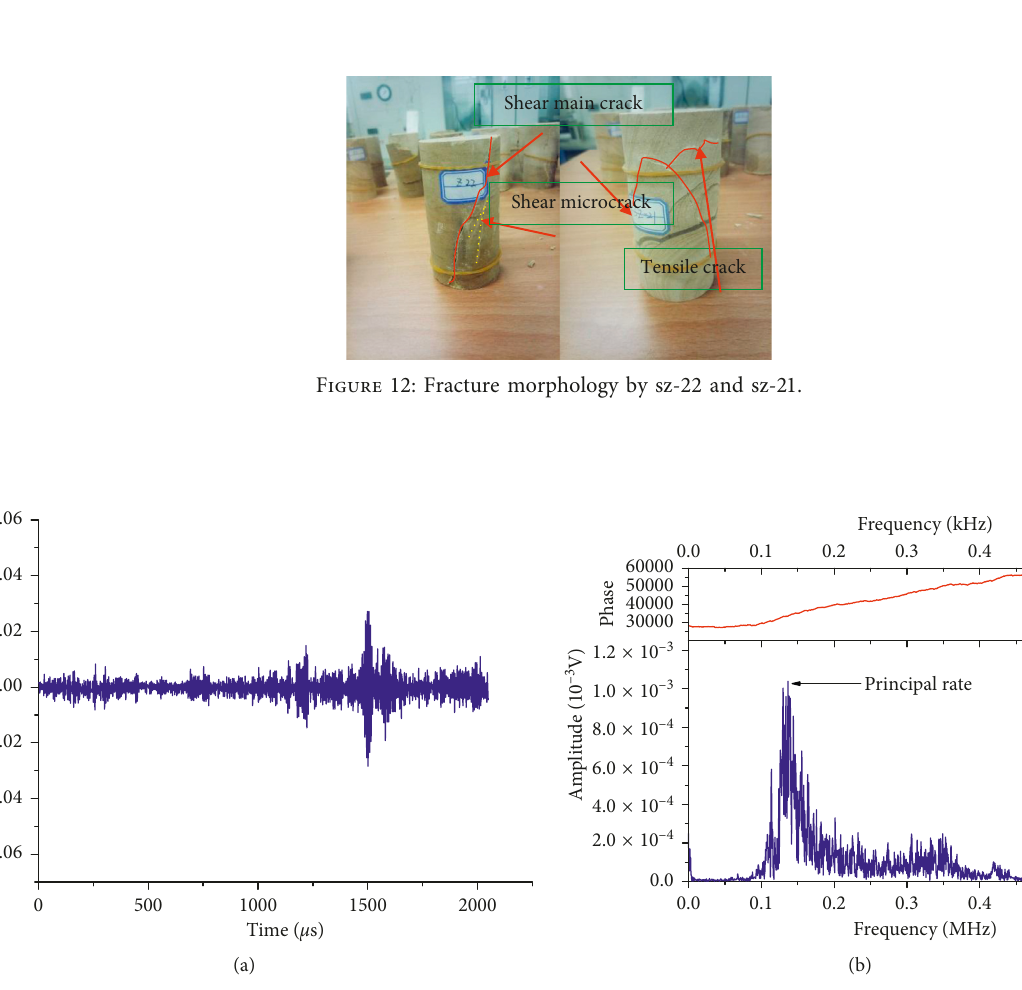
Figure 13: Fourier time-frequency transformation. (a) Waveform signal. (b) Two-dimensional